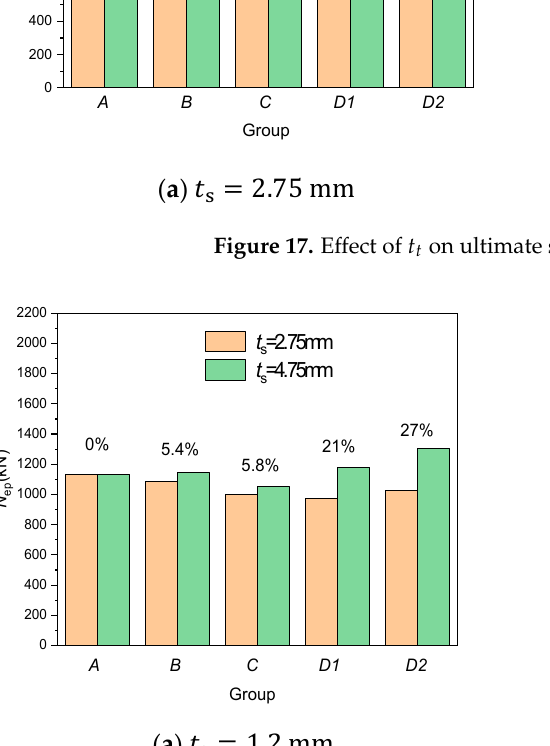
Figure 17. Effect of 𝑡 (cid:2930) on ultimate strength.